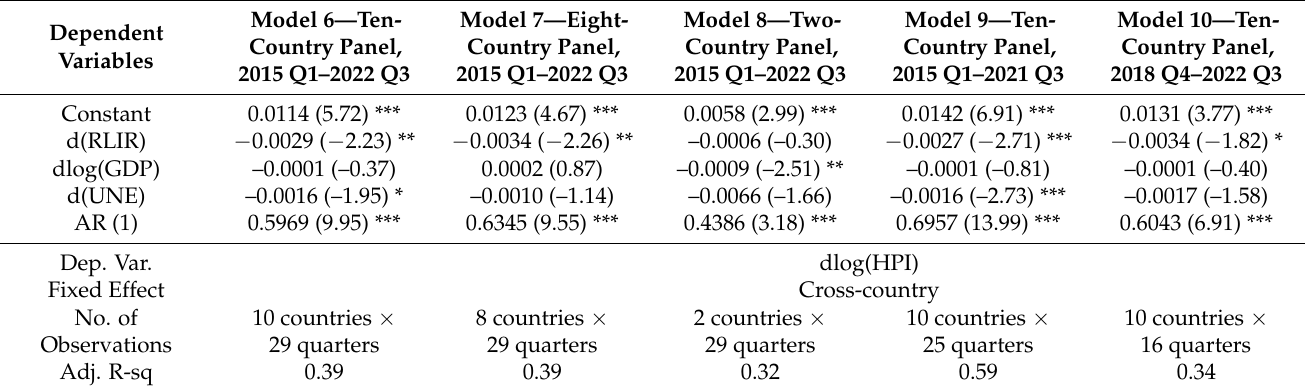
Table 5. Results of the ten-country panel regression models on house price change and real long-term interest rates, with cross-country fixed effect and AR